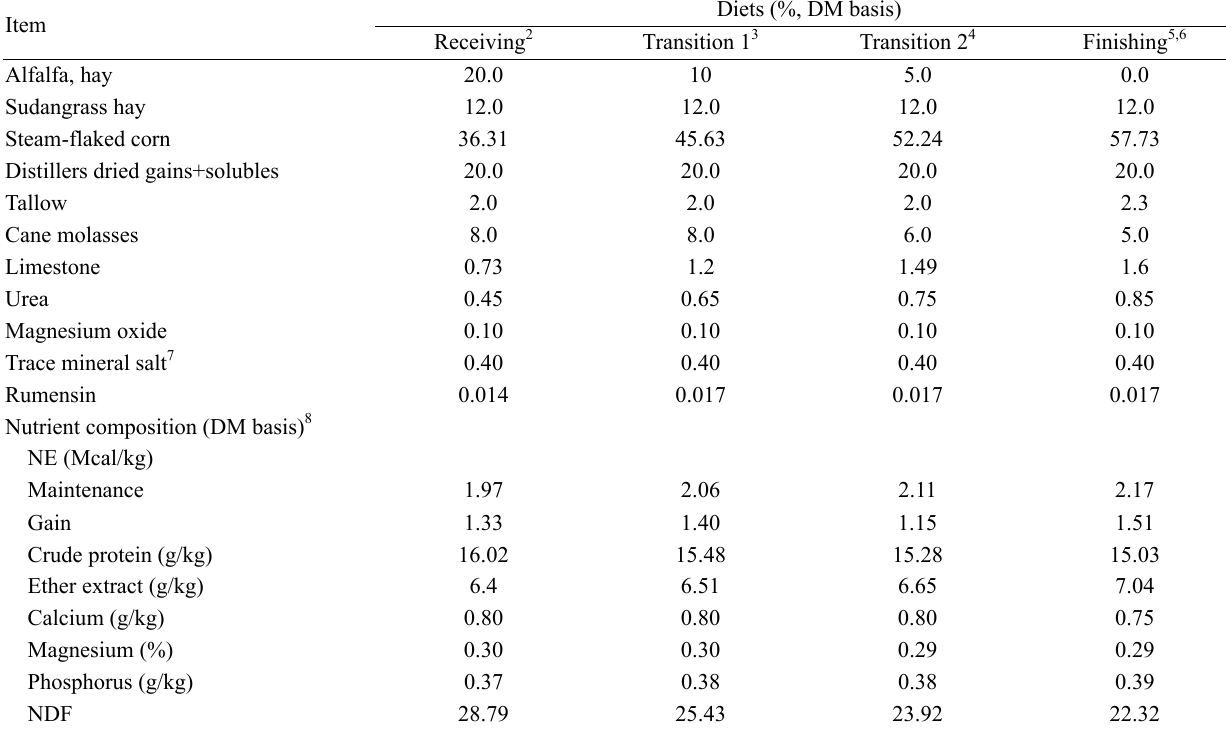
Table 1. Composition of experimental diets fed to steers